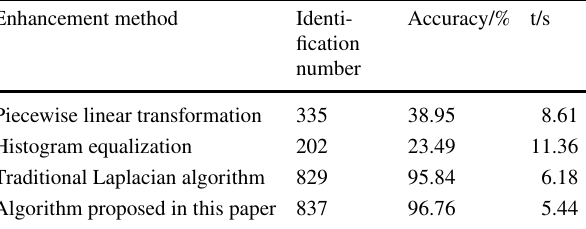
Fig. 22 Character recognition result of wheelset axle end Table 4 Comparison of enhancement